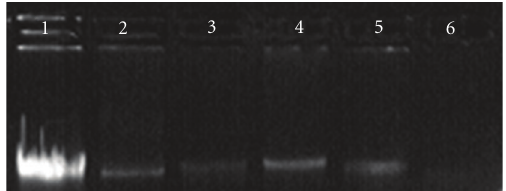
Figure 9: Qualitative analysis of eDNA production. Lane 1: gDNA of A. baumannii AIIMS 7 (Positive control), Lane 2: eDNA produced by E. coli DH5 α -pGEpmt, eDNA, Lane 3: eDNA produced by E. coli DH5 α -pGEM, Lane 4-5: eDNA produced by A. baumannii AIIMS 7, Lane 5: negative control (Luria broth).